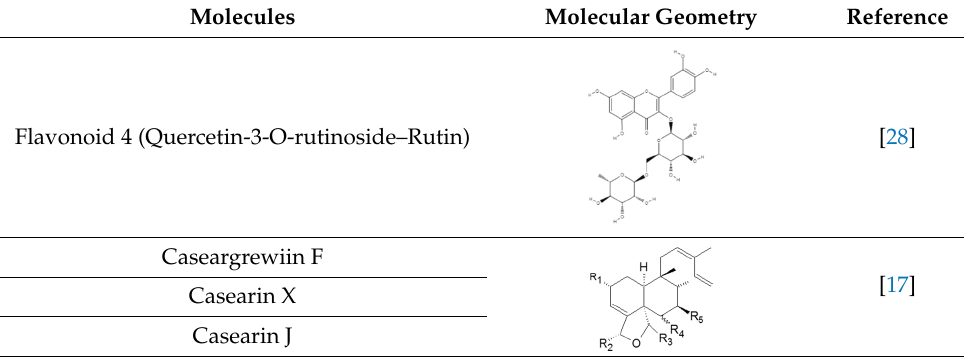
Table 2. Structure of flavonoids and clerodane diterpenes from C. sylvestris .